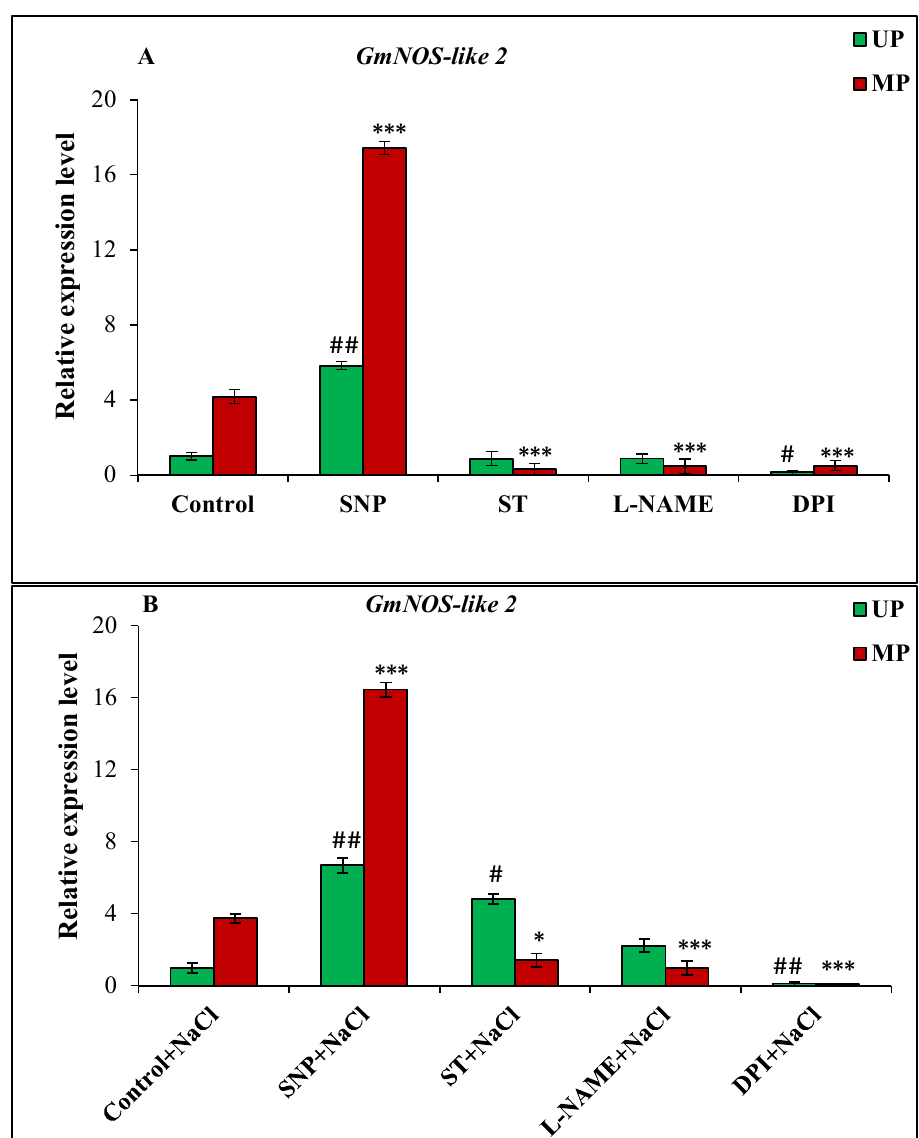
Figure 6. Relative expression analysis of GmNOS-like 2 gene in soybean seeds kept for 24 h in different modulators of NO and ROS production under non-saline ( A ) and saline ( B ) conditions. The data are represented as the means ± SE (n = 3). The fold change in the expression values was calculated using the 2 − ∆∆ CT method given by Livak and Schmittgen [43]. The alpha-tubulin ( Glyma.19G052400 ) gene was used as internal control to normalize the expression, and control UP sample was used as a calibrator in both non-saline and saline treatments. ## p < 0.01, # p < 0.05 indicates the significant difference amongst the UP seeds grown in control with the UP seeds grown in different modulators of NO/ROS under non-saline or saline conditions; *** p < 0.001, * p < 0.05 indicates the significant difference amongst MP seeds grown in control with the MP seeds grown in different modulators of NO/ROS under non-saline or saline conditions.